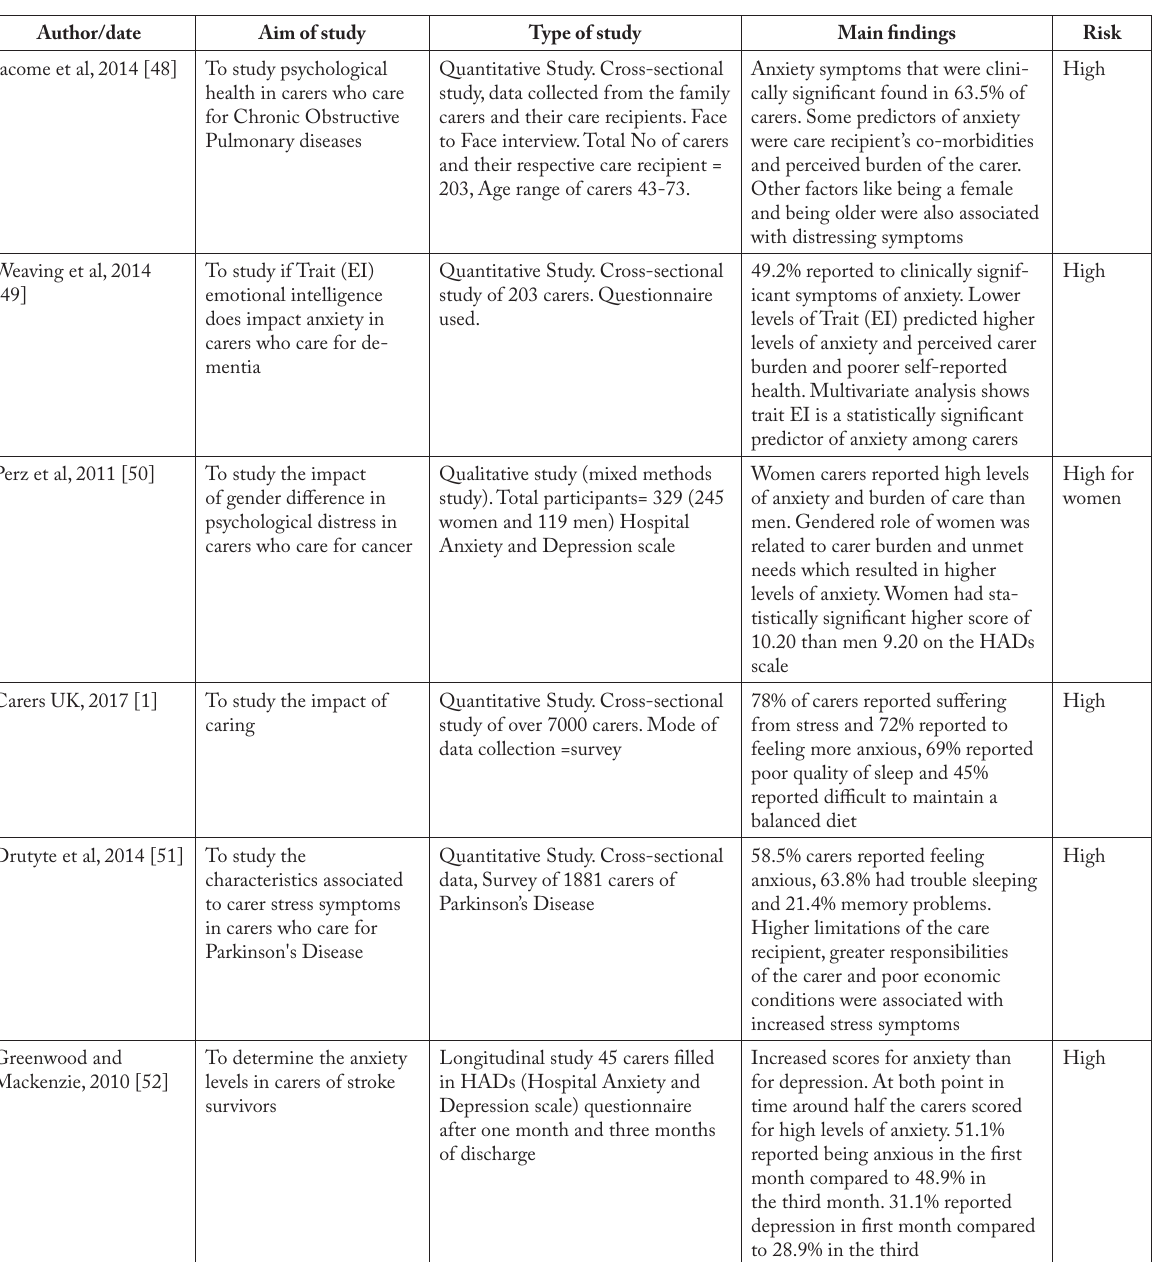
Table 3. Stress and Anxiety among